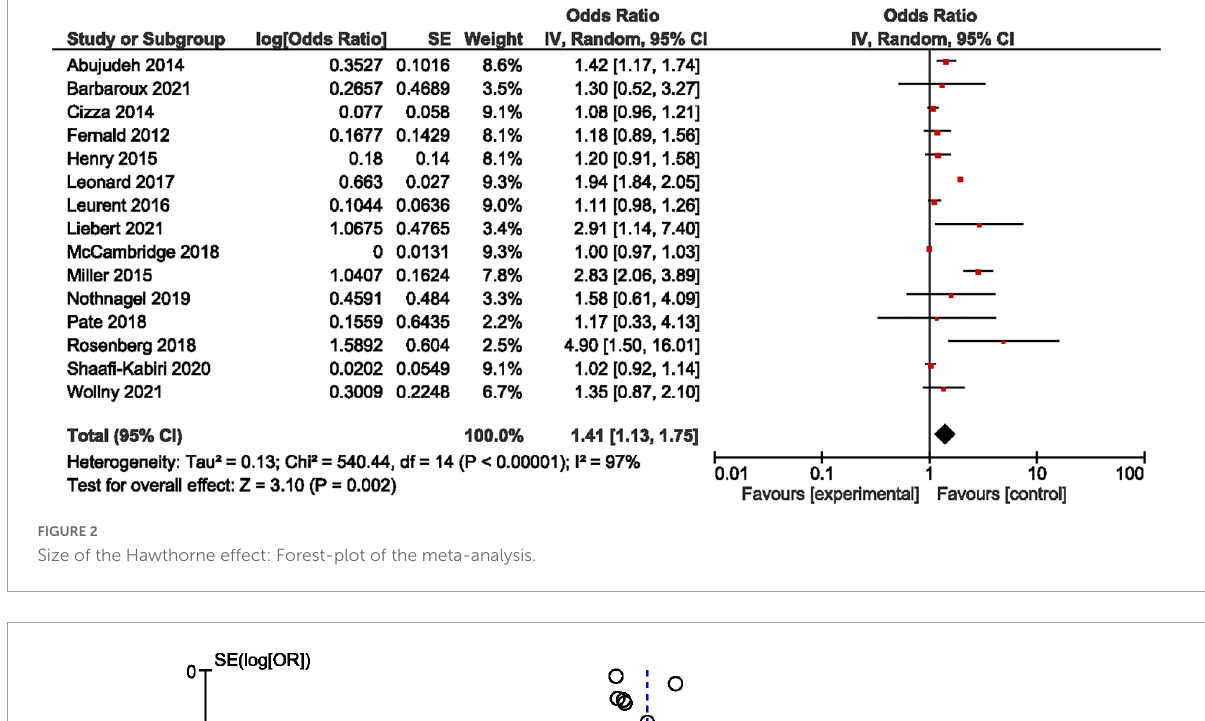
FIGURE2 Size of the Hawthorne effect: Forest-plot of the meta-analysis.